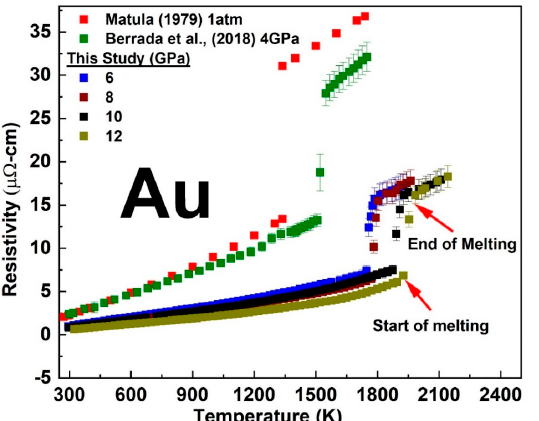
Figure 5. The temperature dependent electrical resistivity of Au at fixed pressure in comparison with previous studies [12,19]. “A” is proportional to (cid:3090)(cid:3024) (cid:3253) ; where λ is the coupling constant, W D is the Debye ( (cid:3272)(cid:3265) ) (cid:3118)